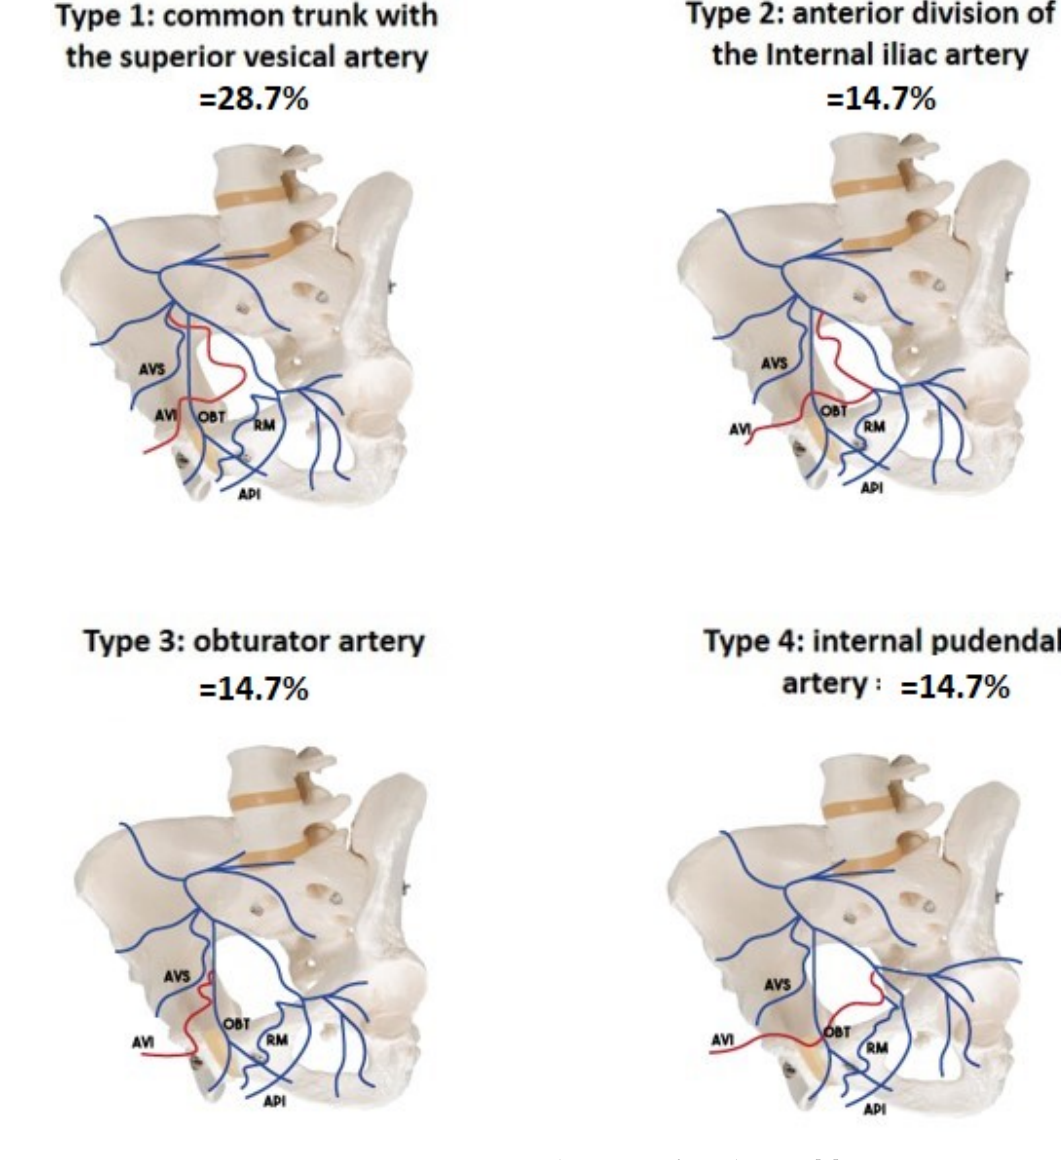
Figure 2. Prostatic artery origin description, from de Assis [6].